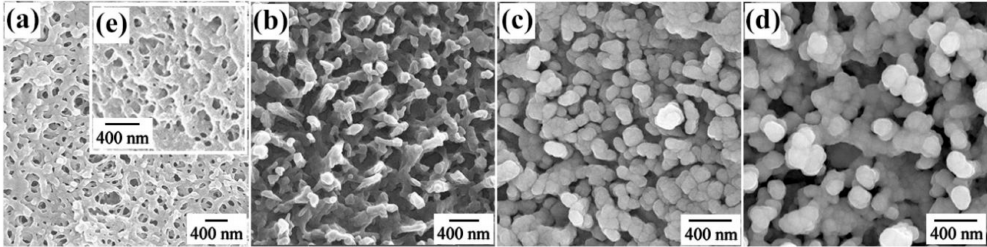
Figure 2. Typical top-view SEM images of the Ag/FCW substrates with different Ag sputtering times: ( a ) 0 min; ( b ) 5 min; ( c ) 10 min and ( d ) 15 min. ( e ) Side-view SEM image of the natural Fulfora candelaria